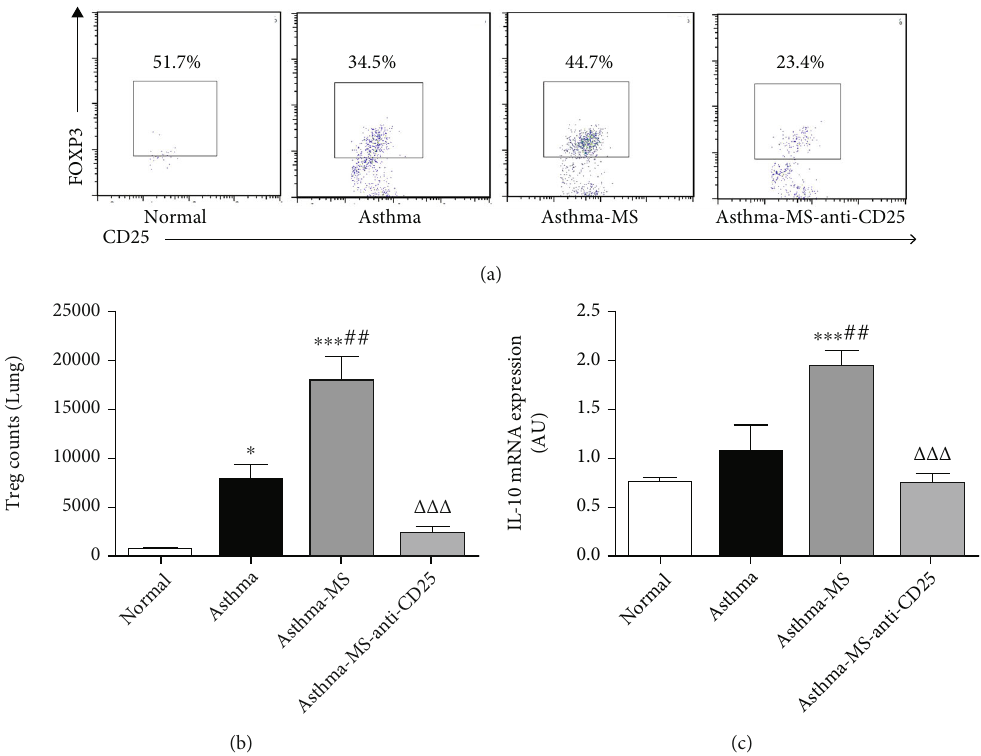
Figure 4: MS prevents excessive in fl ammatory response by stimulating Treg proliferation antagonized by anti-CD25 treatment. A representative fl ow cytometry plot indicates the Treg cell percentage in one lung (a) which is graphically presented in (b). IL-10 mRNA expression in the lungs by anti-CD25 antibody was analyzed (c). The data are presented in the form of the mean ± SEM ( n = 6 per group). ∗ and ∗∗∗ denote P < 0 : 05 and P < 0 : 001 , respectively, versus control group; ## denote P < 0 : 01 , respectively, versus asthma group; △△△ denotes P < 0 : 001 , respectively, versus asthma-MS group.